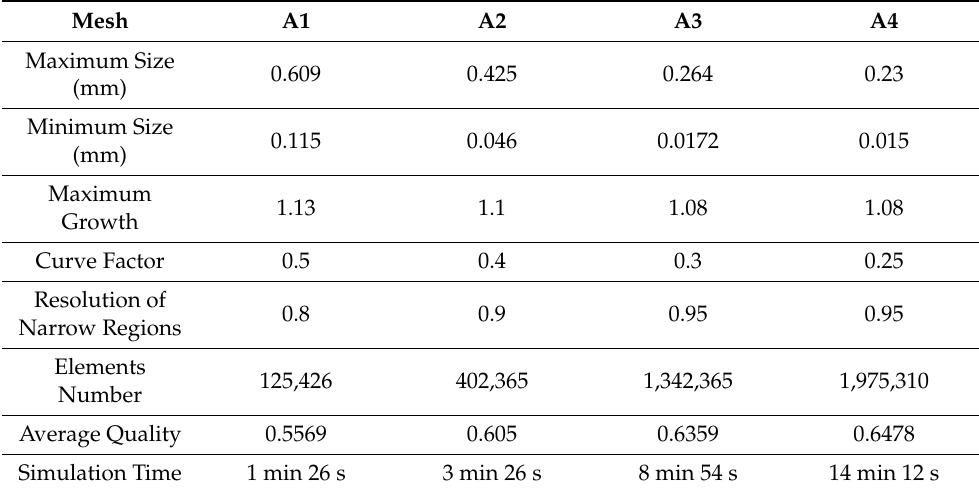
Table 1. Main characteristics of the mesh used for convergence in fluid flow studies.